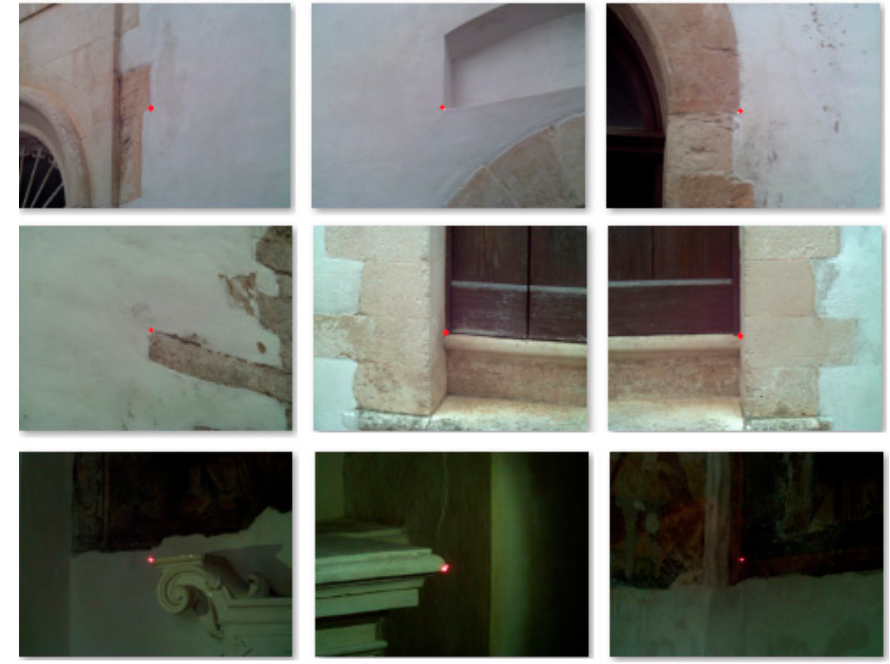
Figure 4. Images of some ground control points used for the georeferencing of the point cloud.